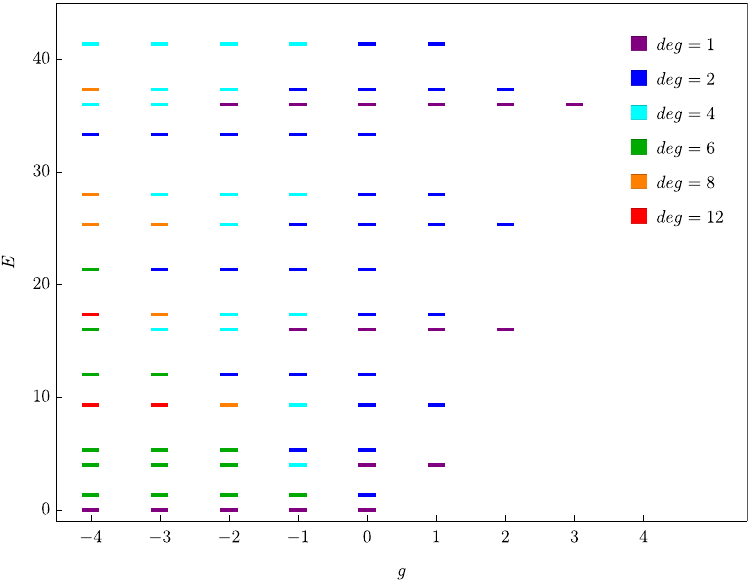
Figure 2 . Low-lying energy spectrum and degeneracies (color-coded) for the A 2 model at integer coupling g 2 Z in the range g 2 [ (cid:0) 4 ;